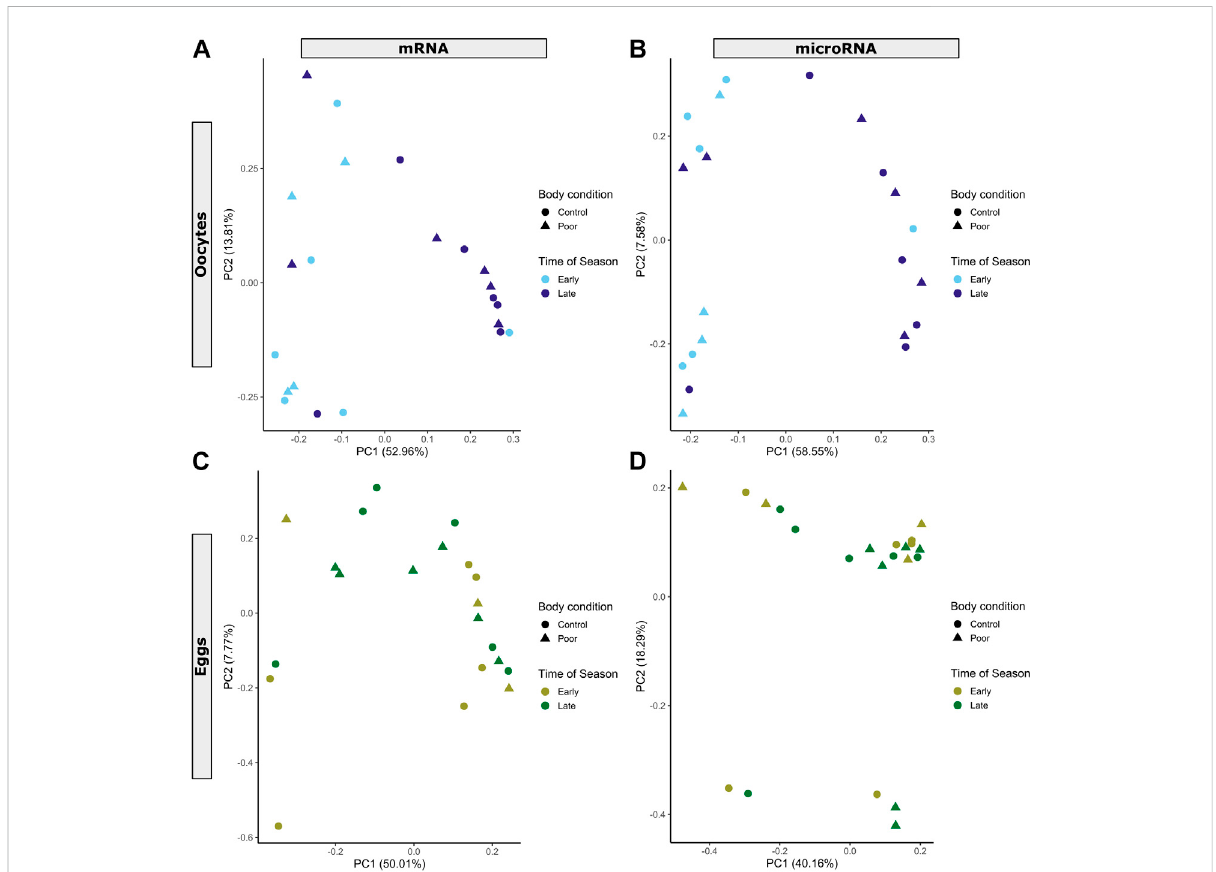
FIGURE 1 Principal component analysis showing mRNA and miRNA expression pro fi les for (A,B) oocyte (blue color scheme) and (C,D) egg (green color scheme)samples.Eachdatapointrepresentsanindividualsample.Manipulationsofmaternalbodyconditionincludedbothcontrol(circle)andpoor condition(triangle)treatmentgroups.Timeofseasonincludesearly(lightshade)andlate(darkshade).Percentofvariancecapturedbyeachprincipal component (PC) is included in the axes labels for PC1 and